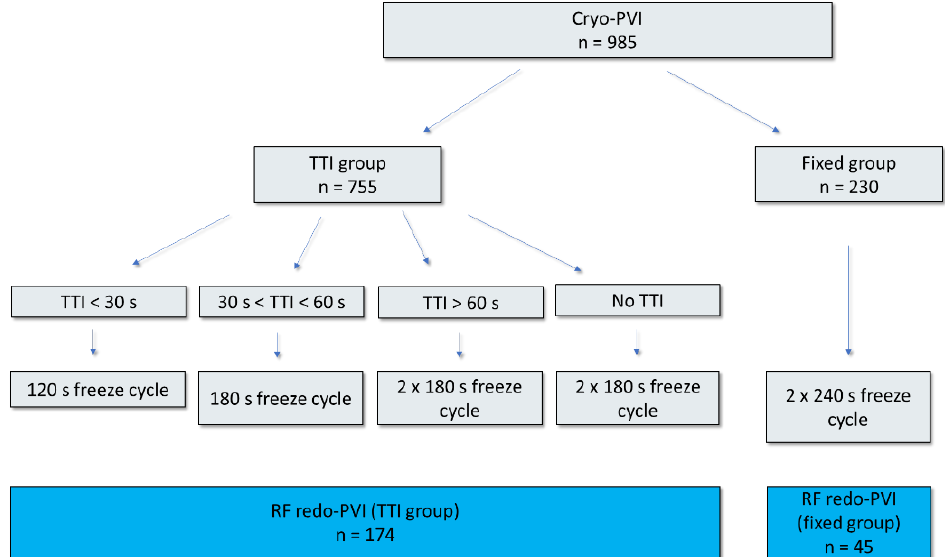
Figure 1. Flowchart that illustrates cryoenergy dosing that depends on TTI (TTI protocol) or a fixed ablation protocol (fixed protocol). Freeze cycles in the TTI protocol were adjusted depending on TTI. Subsequent RF redo procedures were performed in 174 patients (TTI group) and 45 patients (fixed group). PVI—pulmonary vein isolation; RF—radiofrequency ablation; TTI—time-to-isolation.